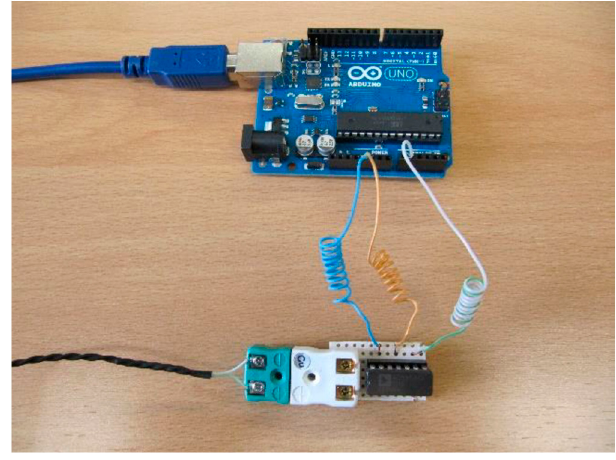
7 of 18 Figure 3. Diagram of the TCMA (top view) and sample disposition.